Question: Name the type of graph shown.
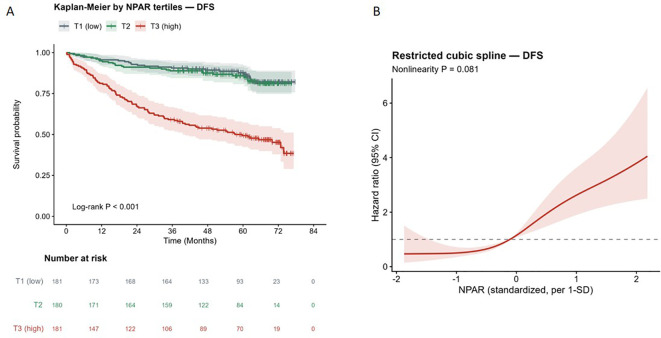
Answer: survival